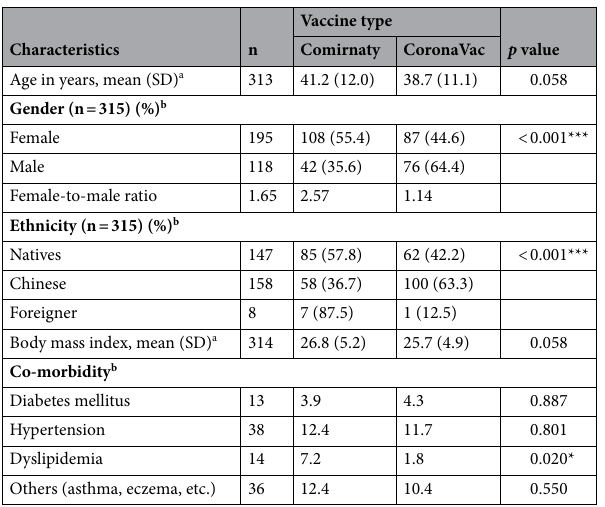
Table 1. Characteristics of vaccinated recipients. a p value was set according to the independent sample t-test. b p value was obtained from the chi-square test. * p < 0.05; ** p < 0.01; *** p <